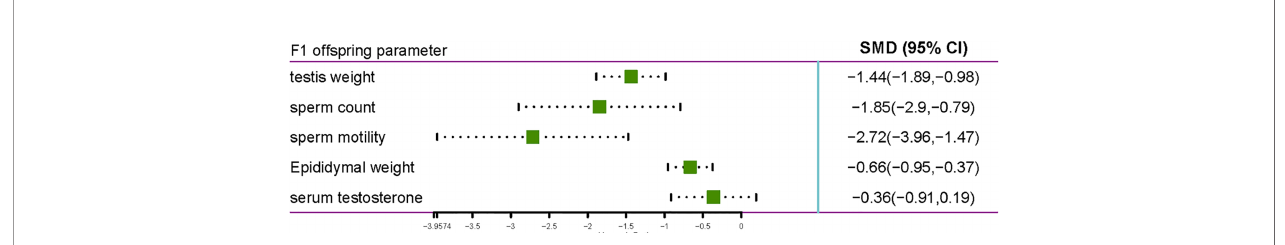
FIGURE 4 | Forest plot showing the effect of pyrethroid exposure on the F1 offspring of rats and mice.